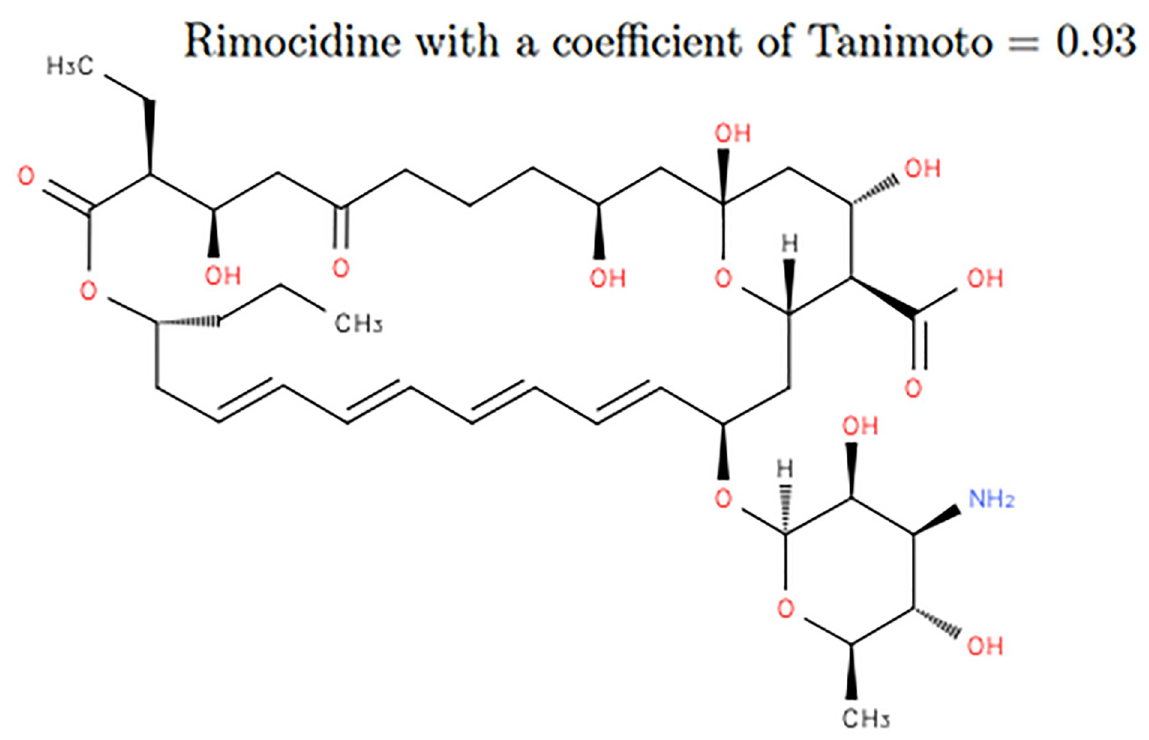
Fig 18. Molecule Rimocidine. Rimocidine (ChEBI id 80106) on TC with a similarity of 0.93.